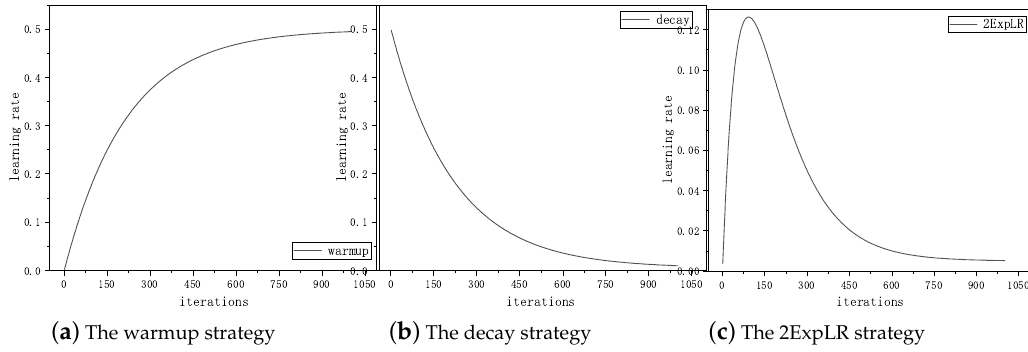
Figure 3. The schematic diagrams of each learning rate